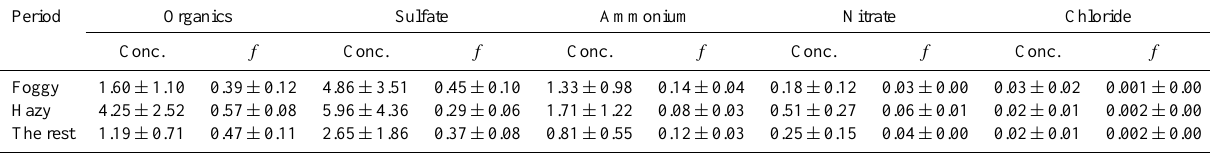
Table 2. The average size-resolved mass concentrations (µgm − 3 , Conc.) and volume fractions ( f ) of chemical compositions from size- resolved AMS measurements during the foggy, hazy and the non-episode periods. Conc. and f were obtained by integrating over the size range ( D m ) from 42 to 1200nm for Fig. 3 a–c and from 42 to 200nm for Fig. 3 d–f. Data are shown as mean ± standard deviations. Period Organics Sulfate Ammonium Nitrate Chloride Conc. f Conc. f Conc. f